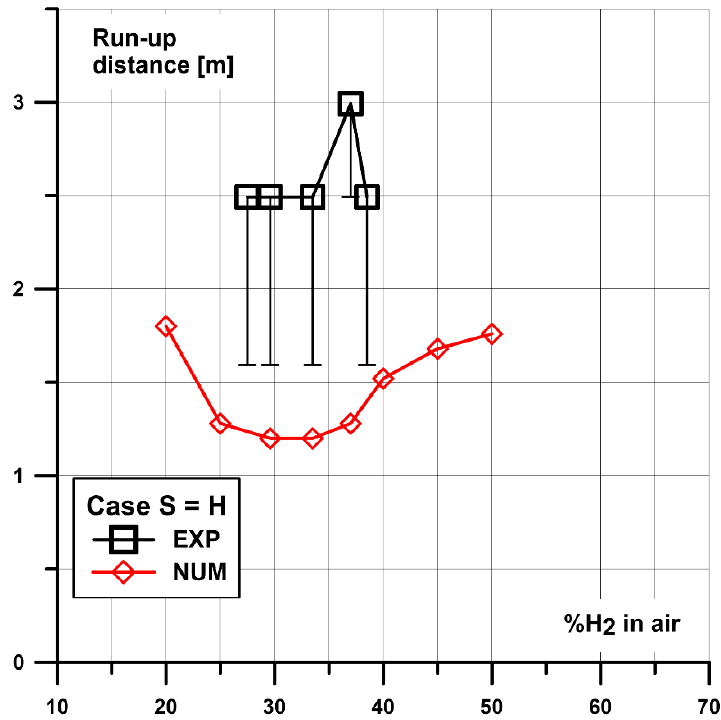
Figure 9. Run-up distances for S = H spacing geometry. Experimental data whiskers cover the dis- tance range of possible transition to detonation placement.